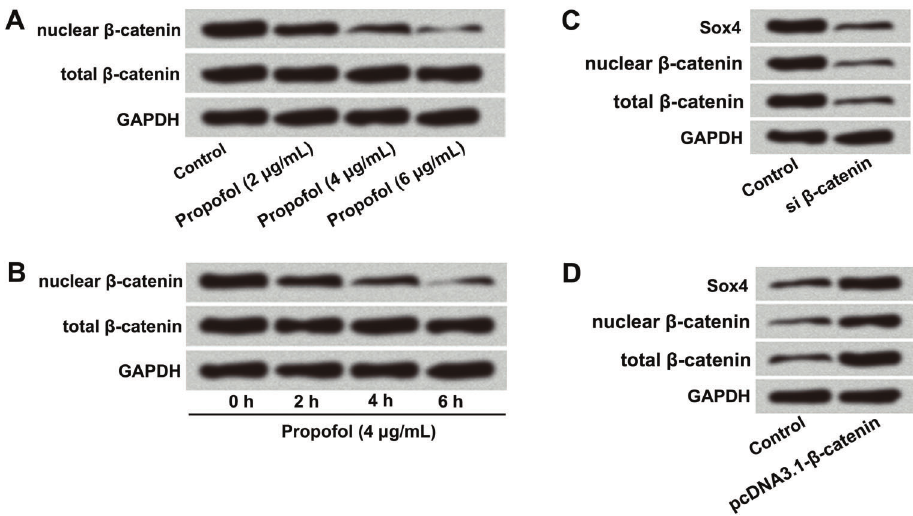
Figure 6. Propofol inhibited Sox4 expression via inactivation of Wnt/ b -catenin signal pathway. Human EC Ishikawa cell line was exposed to different concentrations of propofol (2, 4, and 6 m g/mL). The expressions of nuclear b -catenin and total b -catenin ( A ) in different concentration of propofol and ( B ) in different time points (0, 2, 4, and 6 h) were examined by western blot. The b -catenin siRNA and pcDNA3.1- b -catenin were transfected into Ishikawa cells. In C and D , the expressions of Sox4, nuclear b -catenin and total b -catenin in overexpressing and silencing b -catenin transfected cells were also detected by western blot. EC: endometrial cancer; Sox4: sex- determining region Y-box 4; siRNA: small interference